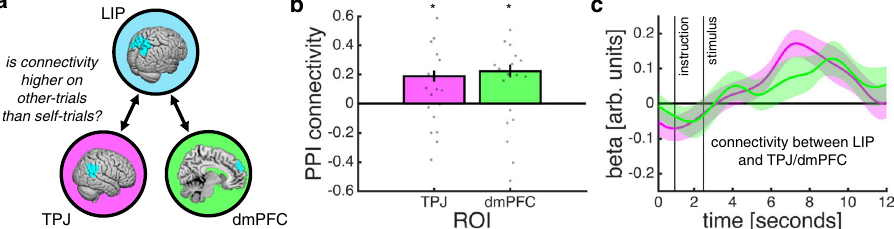
Fig. 8 Functional coupling between sensory and social ROIs during a social con fi dence computation. a Schematic of PPI analysis testing whether the correlation between LIP activity (seed region) and TPJ/dmPFC activity is higher on other- than self-trials. b Contrast estimates from PPI analysis (other > self) as implemented by the Generalised PPI toolbox (asterisk indicates statistical signi fi cance, p < 0.05, one-sample t -test against zero). c Visualisation of activity time courses driving effects documented in b . The time courses are coef fi cients from a regression in which we predicted z-scored TPJ/dmPFC activity time courses using an interaction between z-scored LIP activity time courses and trial type (self = − 0.5; other = 0.5), while controlling for the main effect of each term. b – c Data are represented as group mean ± SEM, n = 21. Source data are provided as a Source Data fi le.